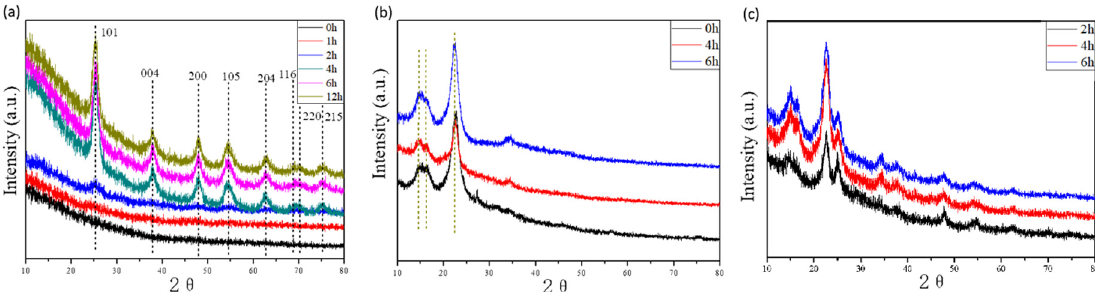
Figure 5. XRD patterns of: ( a ) TiO 2 prepared by sol-gel method with different hydrothermal time, ( b ) chemically crosslinked CNF Aerogel with different hydrothermal time, and ( c ) TiO 2 @CNF Aerogel hydrothermal treated with different time.